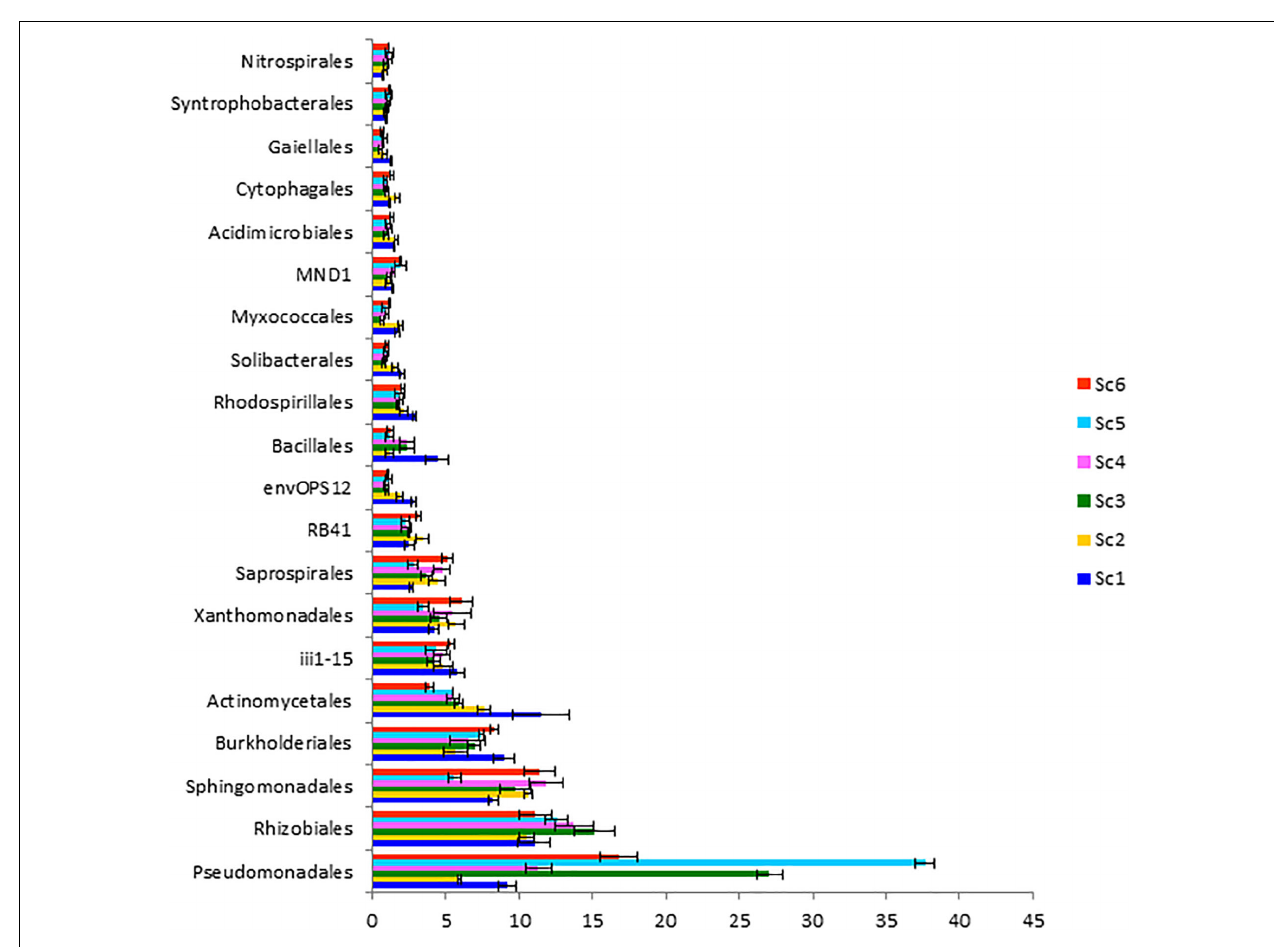
FIGURE 5 | Distribution of dominating orders ( > 1%) in different agriculture management scenarios. Where ; ScI, conventional rice-wheat system; ScII, partial CA based rice-wheat-mungbean system; ScIII, partial CSA based rice-wheat-mungbean system; ScIV, partial CSA based maize-wheat-mungbean system; ScV, full CSA based rice-wheat-mungbean system with sub surface drip irrigation; ScVI, full CSA based maize-wheat-mungbean system with sub surface drip irrigation. The same letters within each column are not statistically different ( P ≤ 0.05, Duncan’s multiple range test) and values are the average of three replicates ( n = 3); means ± standard error